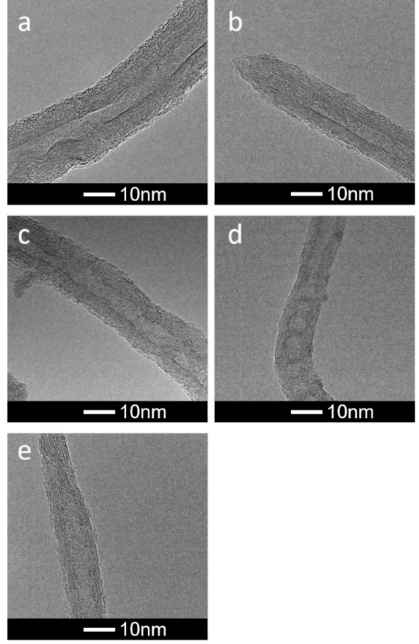
Figure 1. HRTEM images showing the influence of oxidation / unsheathing on the thickness of CNTs applied during the EPD process for oxidation times: ( a ) 10, ( b ) 15, ( c ) 30, ( d ) 75, ( e ) 90 min.